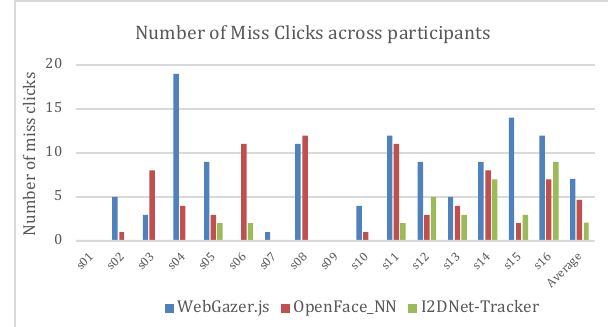
Figure 7. Number of miss clicks for all participants in our user